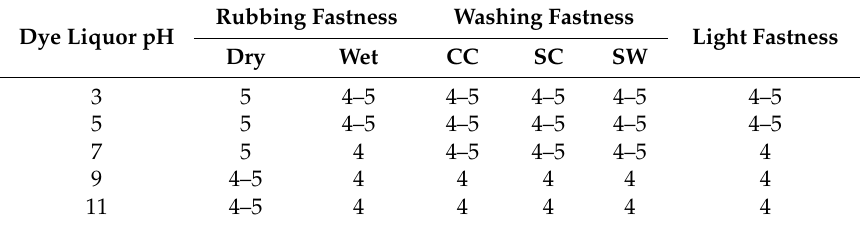
Table 7. The color fastness of dyed wool fabrics under different acid and base conditions. Rubbing Fastness Washing Fastness Dye Liquor pH